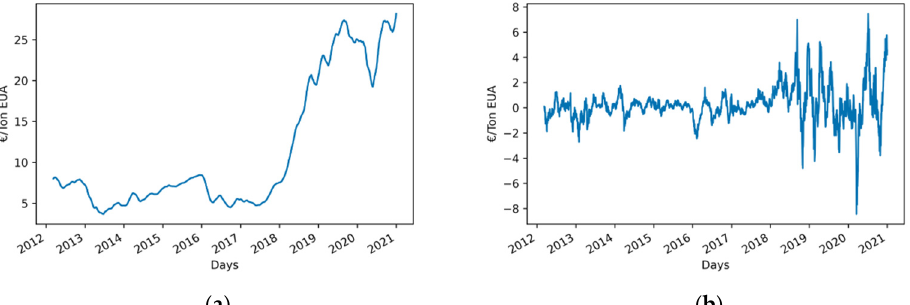
Figure 2. Trend-fluctuation decomposition of daily spot CO 2 prices series: ( a ) Trend series; ( b ) Fluctuations series.